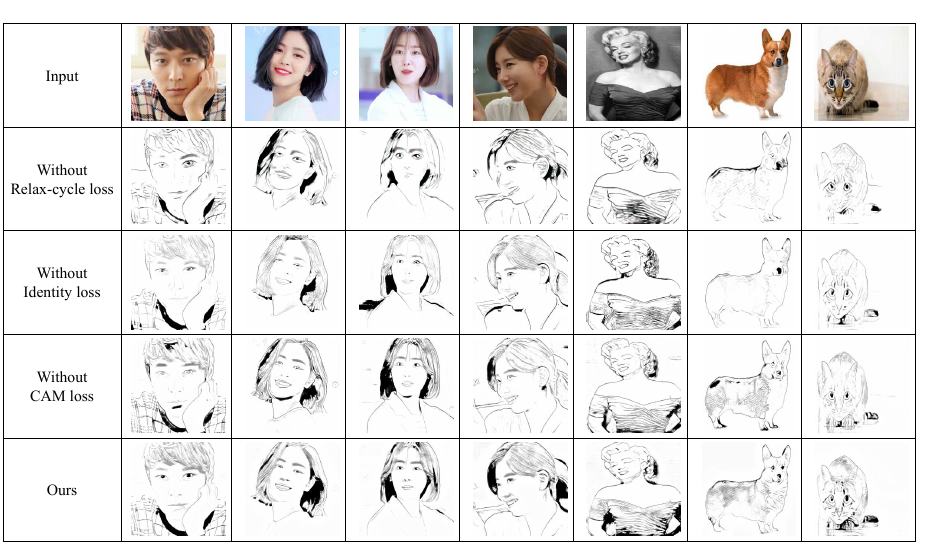
Figure 15. Ablation study on loss terms.